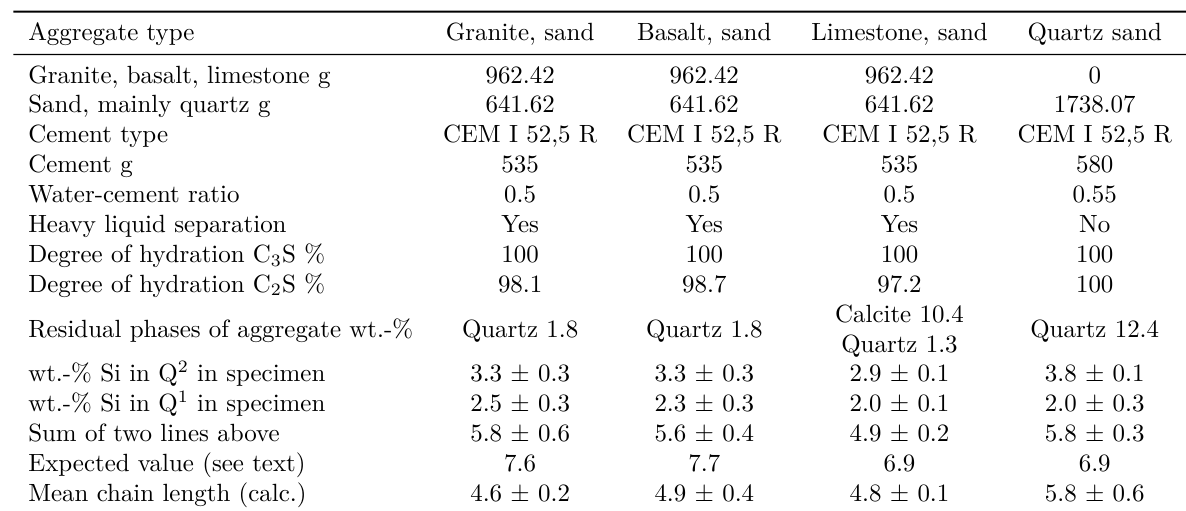
Table 4. Plausibility tests with binders of hydrated mortars.